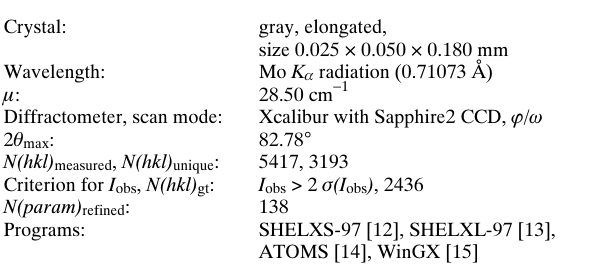
Table 1. Data collection and